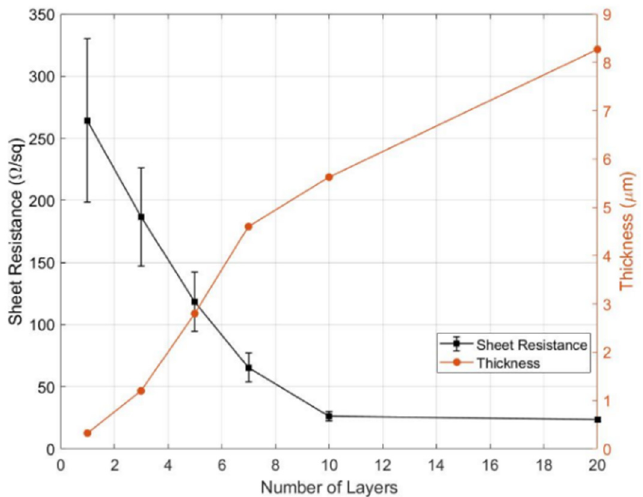
Figure 9. The sheet resistance and thickness with respect to the number of layers.